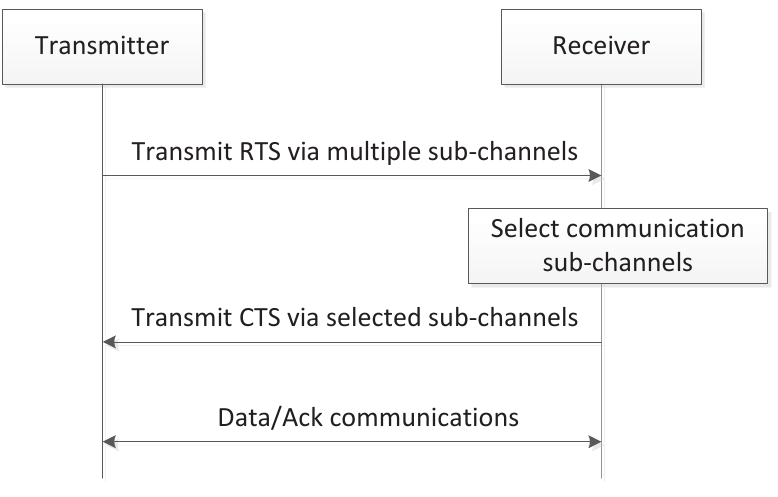
Figure 2. Flowchart for dynamic bandwidth